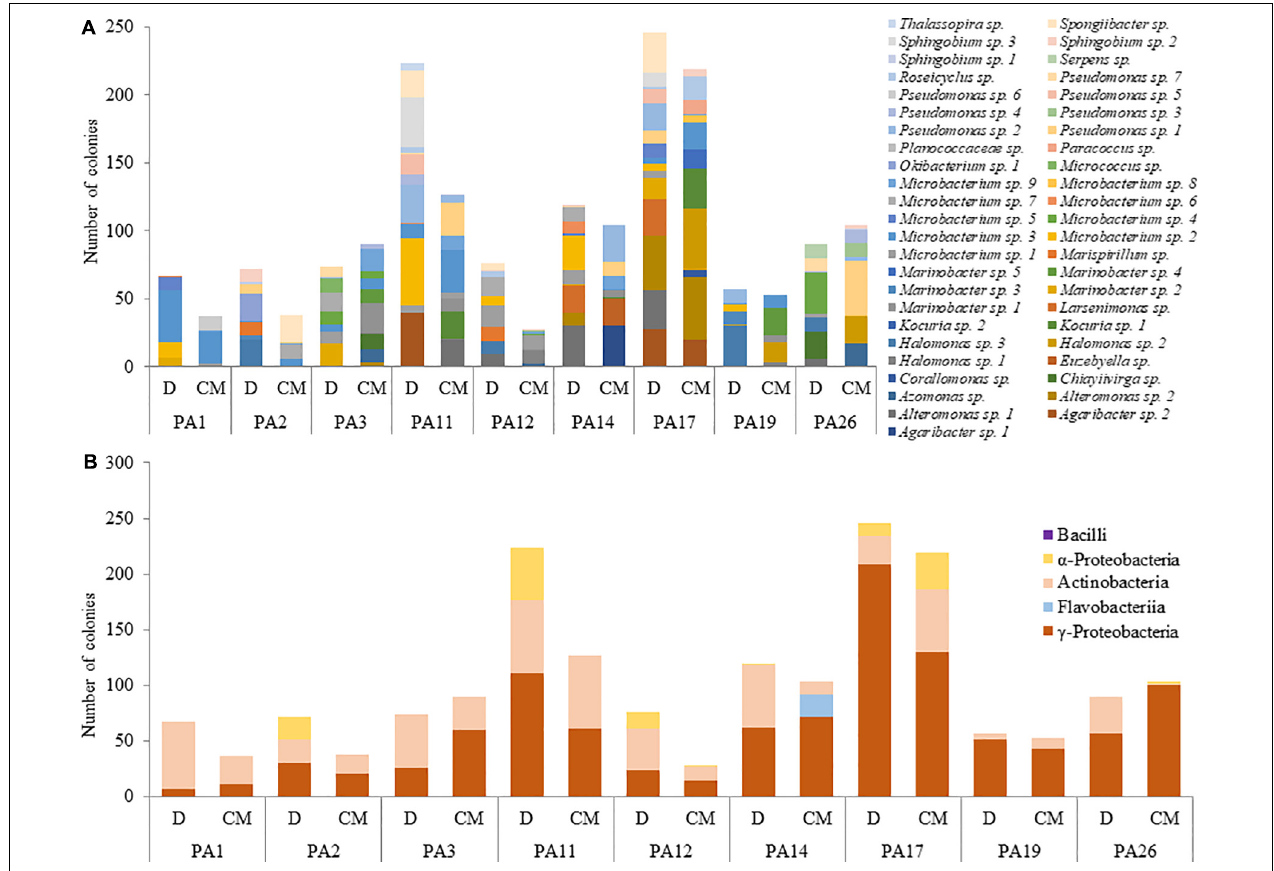
FIGURE 3 | Abundance of cultured bacterial genera/species (A) and classes (B) from dinoflagellate cell-aggregates (D) and culture medium